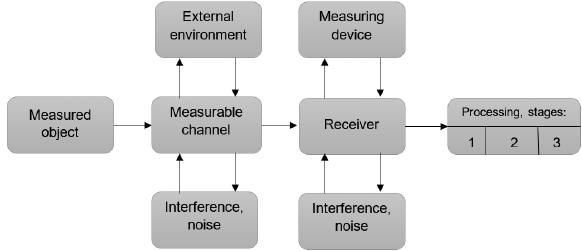
Figure 1. Generalized information transmission chain (measured